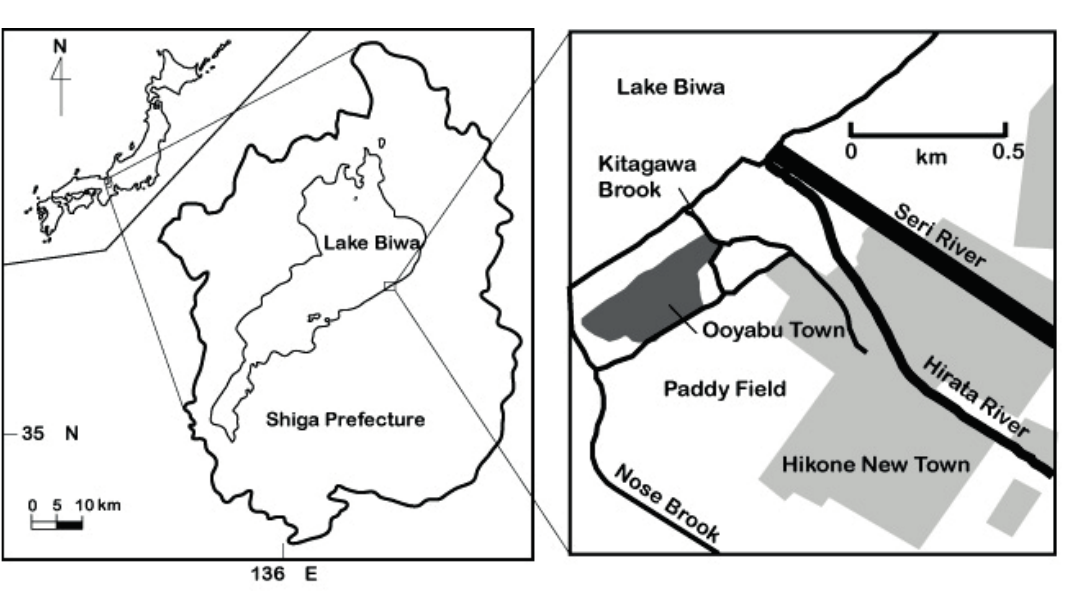
Fig. 1 Map of the study